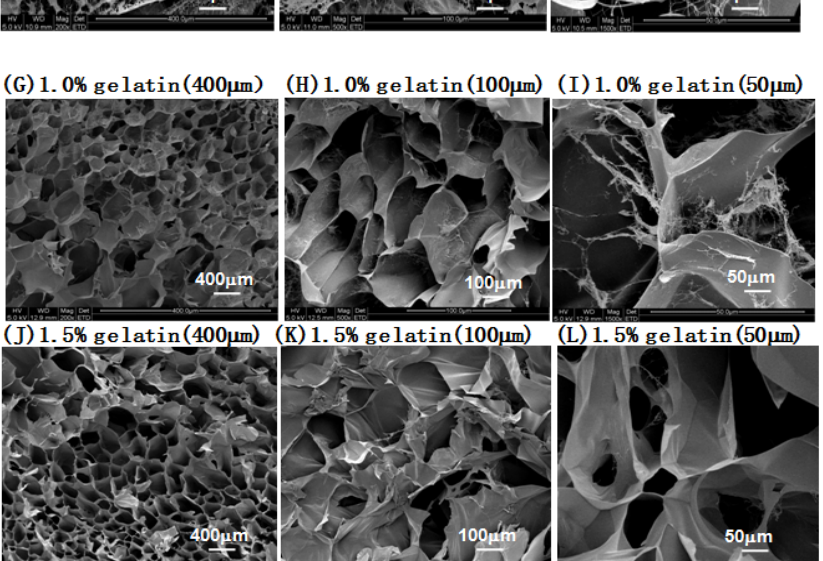
Figure 3. SEM images of sustained-release preparations based on different gelatin concentrations. (A − D) SEM images of sustained-release preparations based on different gelatin concentrations. After lyophilization, the microstructures of the gel were cut into longitudinal sections and visual-